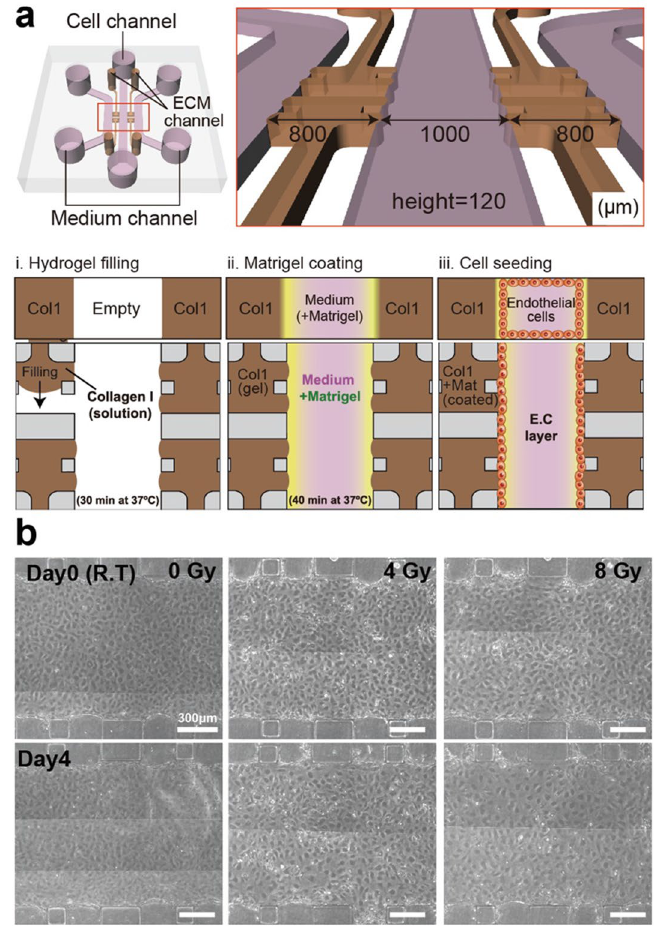
Figure 1. Schematic overview of endothelial barrier formation in our 3-D microfluidic chip and phase-contrast images of endothelial monolayer at day 0 and 4 according to irradiation doses (non-treated (0 Gy), 4 Gy, and 8 Gy). ( a ) Our microfluidic chip has three channels for seeding the cells and supplying the medium, and four regions for filling the hydrogels. After filling the hydrogels and remodeling the ECM according to our previous study, the hMVECs were cultured in central channels; they formed a monolayer within 4 days. ( b ) Phase- contrast images of the hMVECs monolayer in the microfluidic chip before and after the gamma irradiation treatment that was dose dependent. (Scale bar: 300 µm) Schematic and phase-contrast images were created with Adobe illustrator (CC 2019 23.0.1, www. adobe.